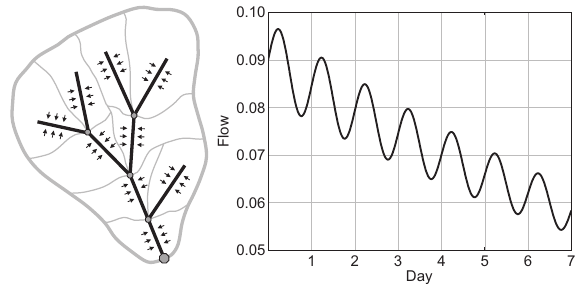
Figure 2. The left panel shows how runoff enters the river network as lateral flow from each hillslope to its adjacent link. The right panel shows a sample baseflow pattern given by Eq. (1) using A = 0 . 003 [h − 1 ], B = 0 . 08 [Ls − 1 ], C = 0 . 008 [Ls − 1 ], ν = 1 and φ = 0 [ h ]